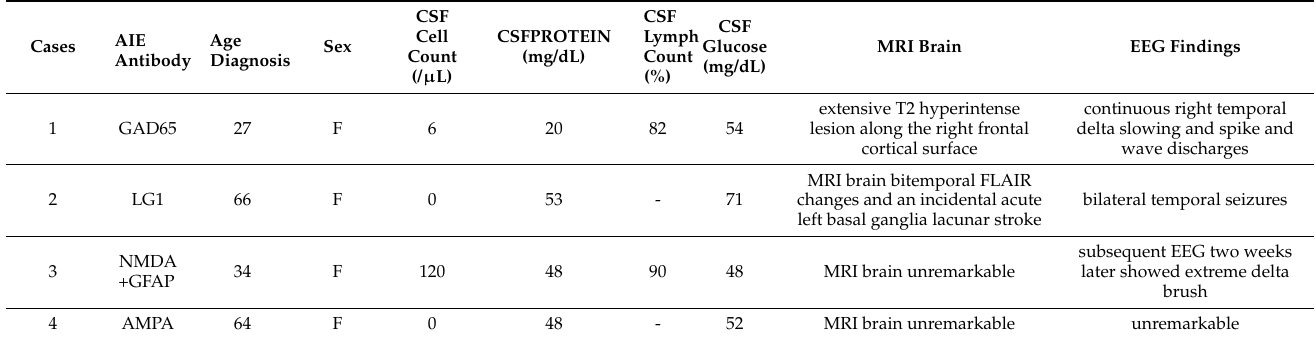
Table 1. Summary of Clinical Characteristics and Neuroimaging and CSF findings of AIE